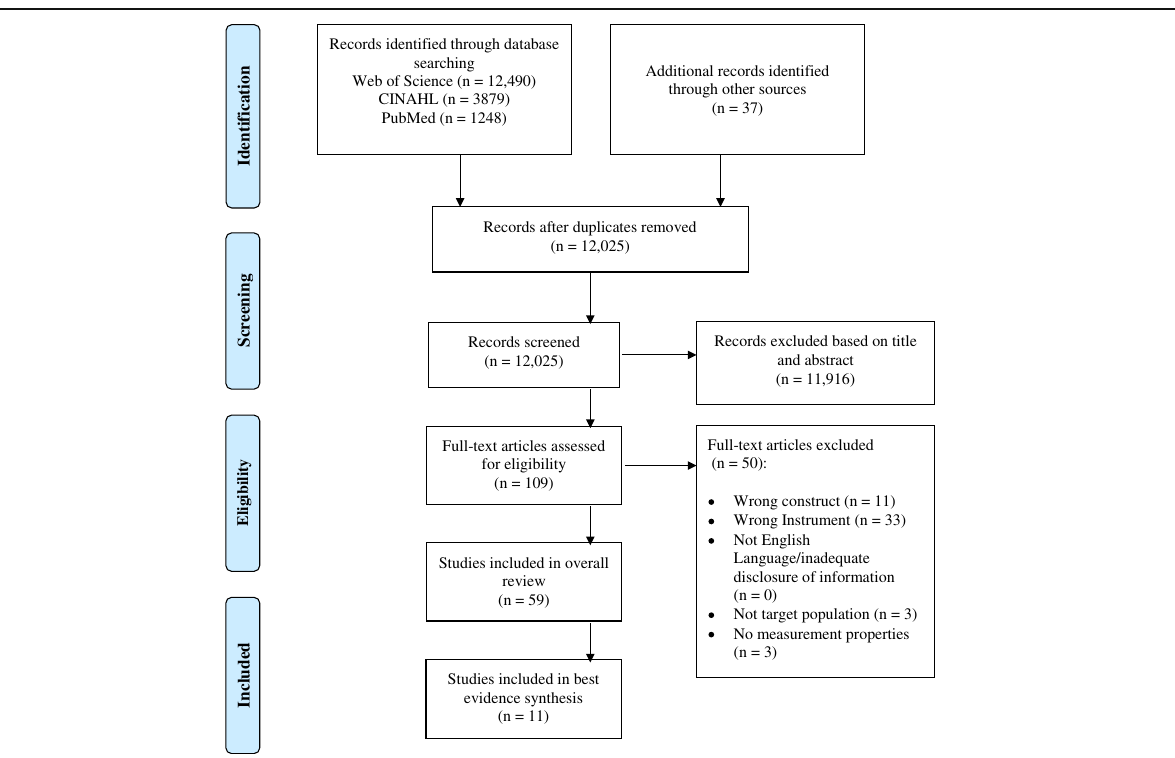
Fig. 1 Flow chart of study selection and eligibility